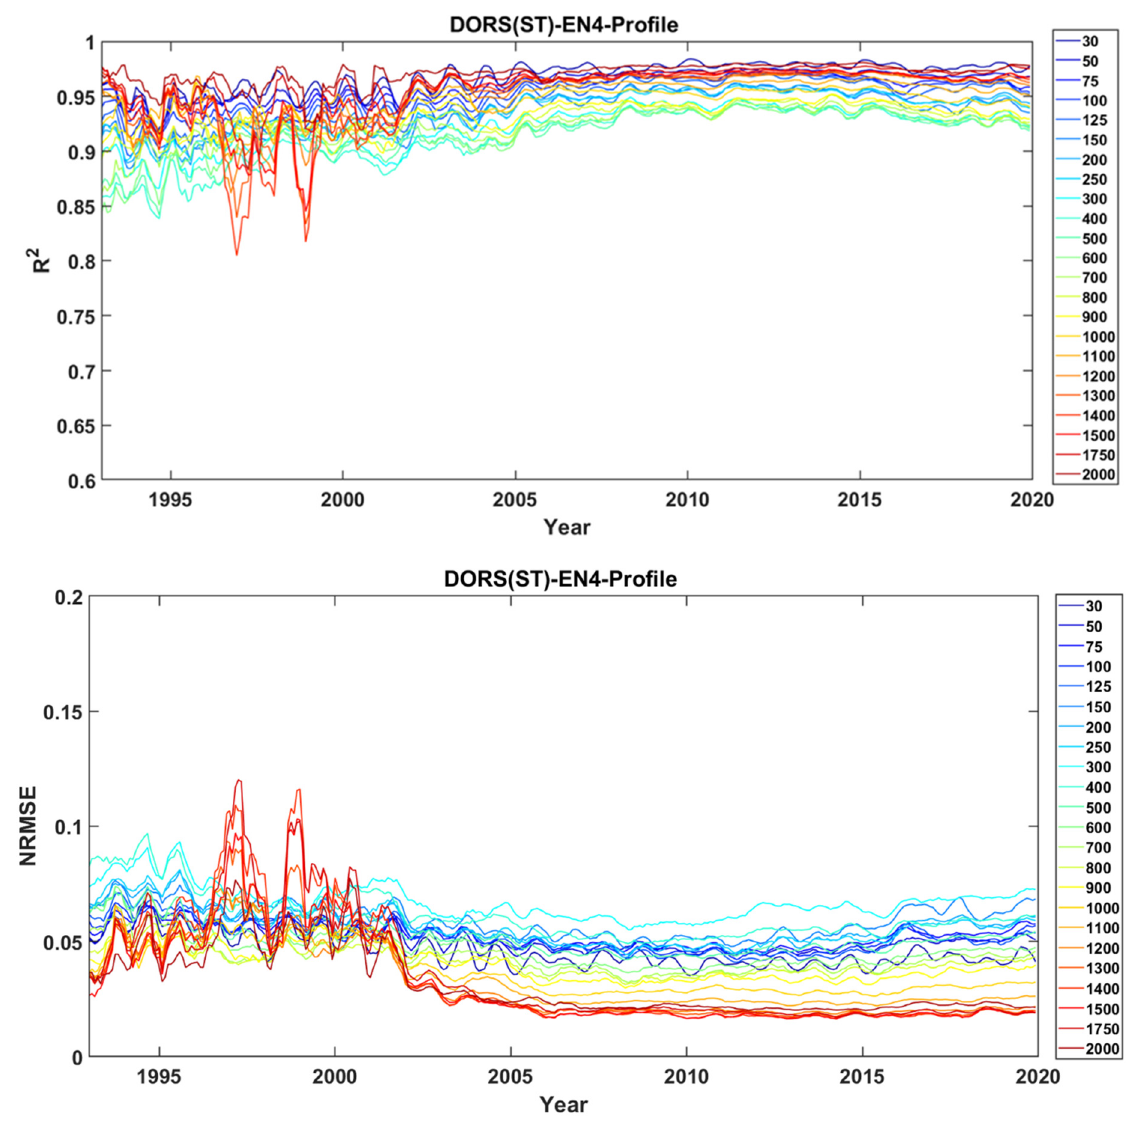
Figure 4. ( a ) Time series mean R 2 and RMSE at different depths for DORS relative to the Argo, IAP, EN4, Ishii, and ARMOR3D datasets. ( b ) Depth-averaged R 2 of DORS relative to the Argo (from 2005 to 2019), IAP, EN4, Ishii, and ARMOR3D datasets over long time series. ( c ) The R 2 and NRMSE at different depths in the upper 2000 m validated by the EN4-Profile dataset from 1993 to 2020. The lines in the figure were smoothed by running a mean filter for 6 months.